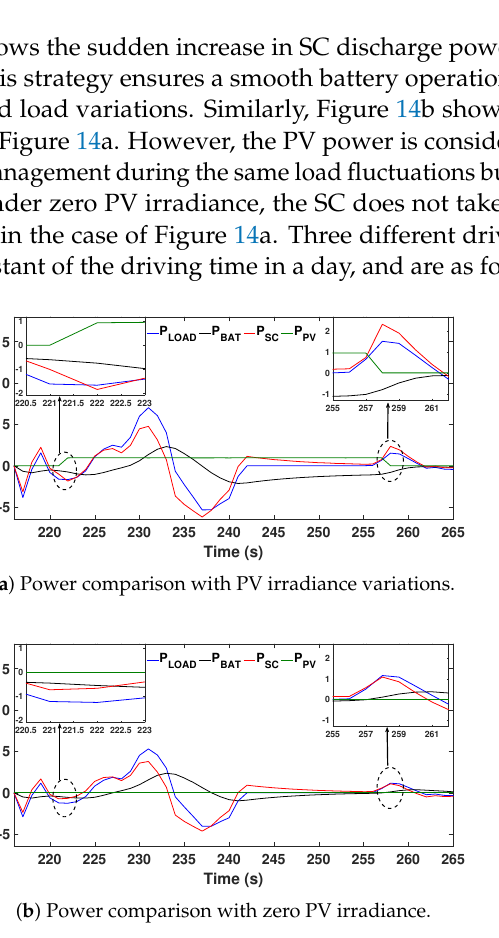
Figure 14. Power allocation of IHSEMS for sudden variation in solar irradiance ( a ) at zero PV power; ( b ) under NYCC driving